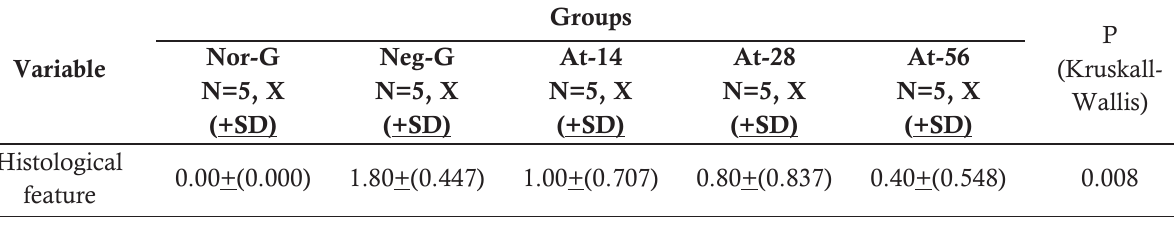
Note: Every islets in each sample were assessed, and the score that appears the most (mode) was chosen to represent the histological Table 2. Pancreas Histopathological Image from each group Table 2. Pancreas Histopathological Image from each group Table 2. Pancreas Histopathological Image from each group